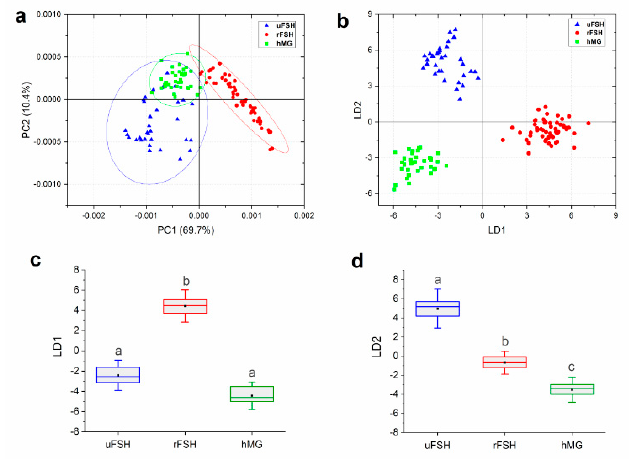
Figure 6. Multivariate statistical analysis of spectral data: ( a ) scores plot of the 2 first principal components after PCA performed on IR spectra collected from uFSH, rFSH and hMG CCs samples. The percentage of variance explained by each Principal Component (PC) is indicated inside parentheses. Ellipses indicate 95% confidence. ( b ) Principal Component Analysis-Linear Discriminant Analysis (PCA–LDA) scores plot for uFSH, rFSH and hMG CCs samples. LD1 and LD2 represent the first and second linear discriminant functions obtained by the canonical variables scores of PCA–LDA. ( c ) One-dimensional scores plots of LD1 and ( d ) LD2 for uFSH, rFSH and hMG CCs samples. Box chart legend: centerline = median; blacksquare = mean; edges = 25thand75thpercentile; whiskers = standard deviation. Di ff erent letters over box charts indicate statistically significant di ff erences among groups (one-way ANOVA and Tukey’s multiple comparisons test). Statistical significance was set at p <